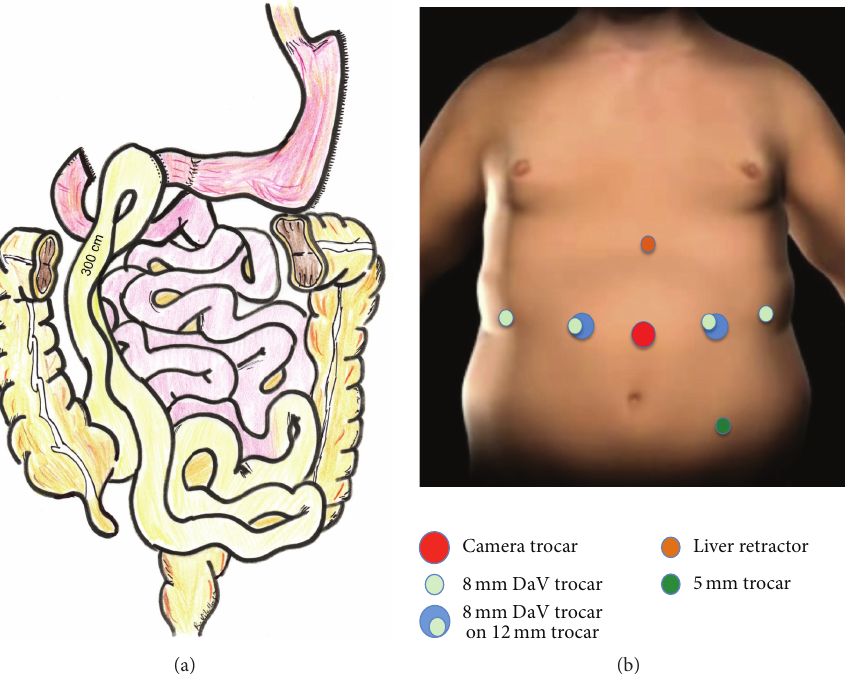
Figure 1: The SADI bypass includes a single duodenoileal anastomosis performed 300 cm from the ileocecal valve (a). Trocar placement according to the described technique